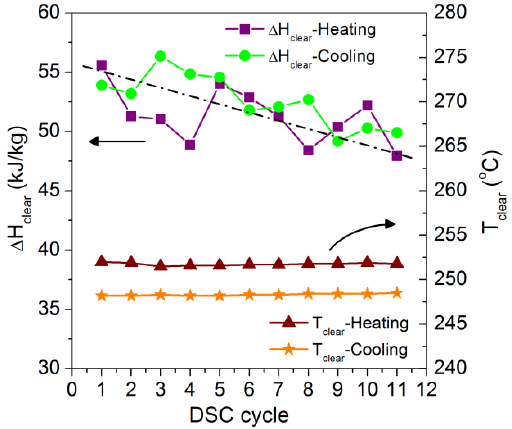
Figure 8. Clearing temperatures and enthalpies obtained for each DSC heating and cooling cycle performed to 10-BPhCOOH.